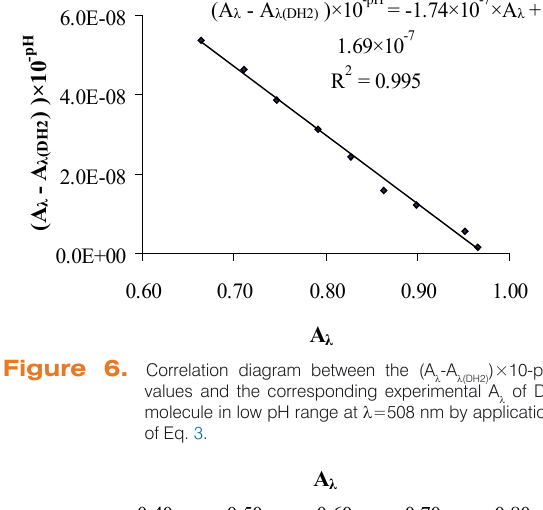
-A )×10-pH λ λ (DH2) of D3 λ